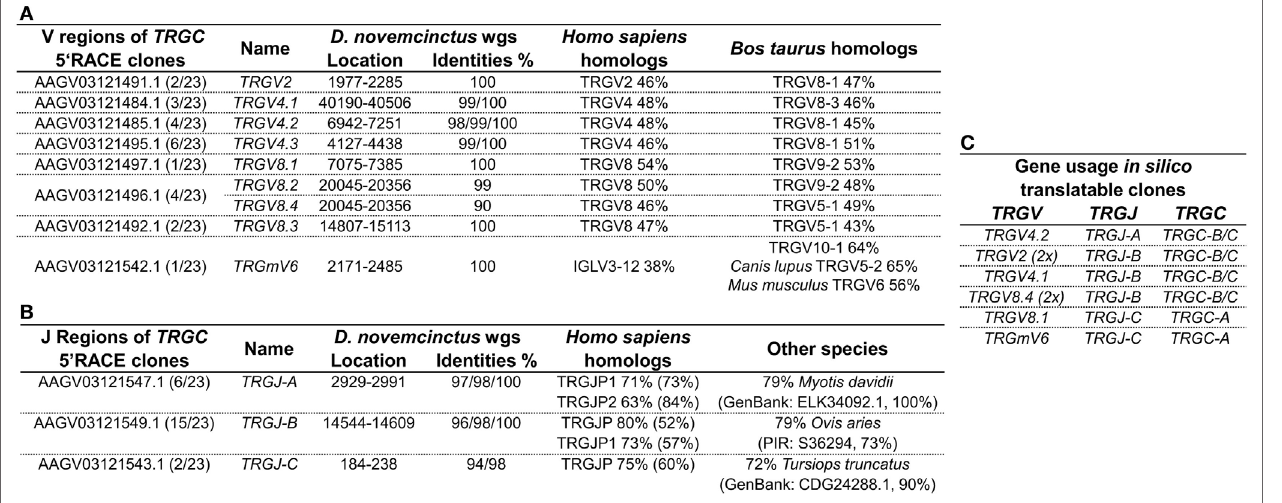
FigUre 4 | Gamma chain transcripts homologous to human IMGT subgroup TRGV1 are expressed in armadillo PBMCs. (a) Dasypus novemcinctus TRGV regions used by 5 ′ RACE PCR products (Accession: TRGC-A Ex1 AAGV03121543.1; TRGC-B Ex1 AAGV03121550.1; TRGC-C Ex1 AAGV03121548.1) with associated wgs accession numbers based on sequence homologies and location of those in the respective contigs. Armadillo TRGV segments were labeled according to their closest homolog in human or mouse. Varying nucleotide identities to genomic sequences and putative AA homologs in human and other species are indicated. AA homologs were determined with IMGT/DomainGapAlign (57, 58). (B) J regions of TRGC 5 ′ RACE clones with location in wgs contigs and identities. Designations of J regions of the armadillo are random as distinct homologs to human TRGJ could not be determined. Homologies were determined by NCBI blastp to AA sequence of human germline encoded J regions or the NCBI non-redundant protein sequence database for other species. (c) Gene usage of in silico translatable TRGC 5 ′ RACE clones. The GenBank accession numbers of productive rearrangements are supplied in Table S2 in Supplementary